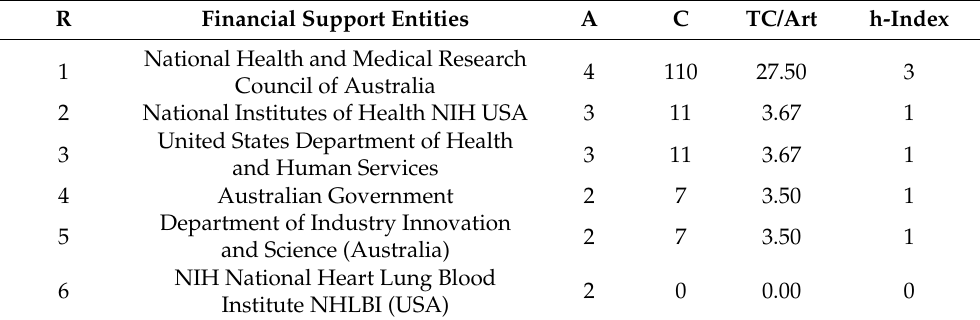
Table 5. Most relevant financial support